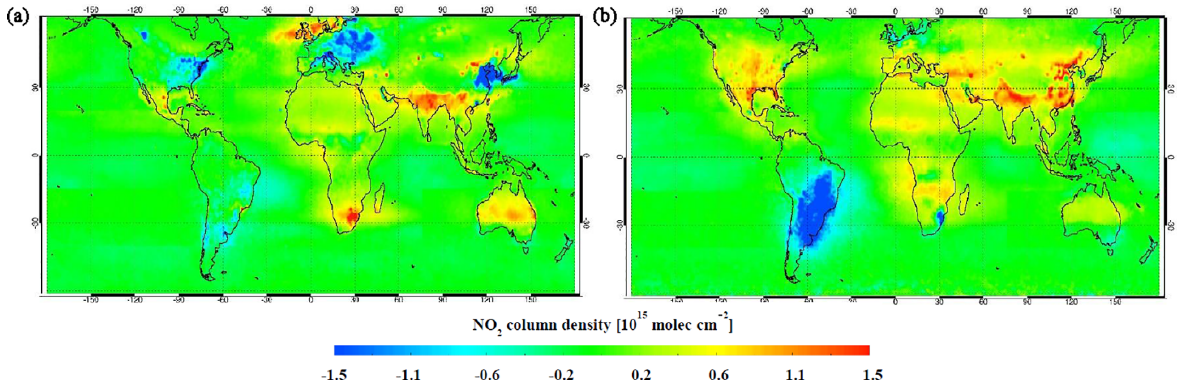
Figure 15. Difference in tropospheric NO 2 columns from GDP 4.9 and GDP 4.8 for clear-sky conditions (cloud radiance fraction smaller than 0.5) in February (a) and August (b) 2007–2016 for